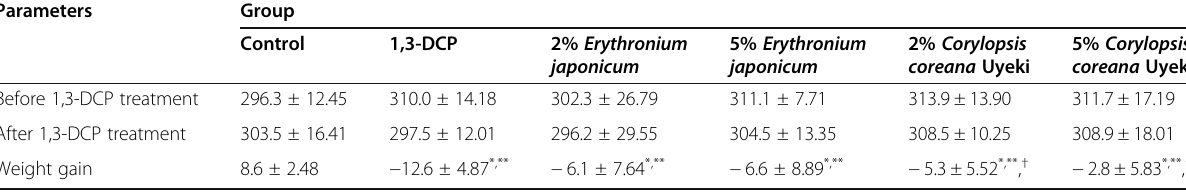
Table 1 Body weight changes in male rats Parameters